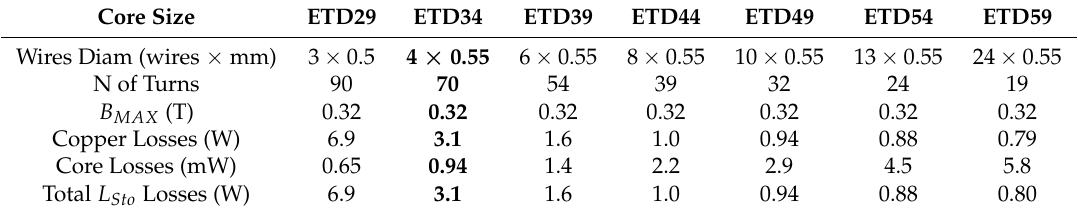
Table 9. Main Inductor Design Outputs for ( L Sto = 300 µ H).